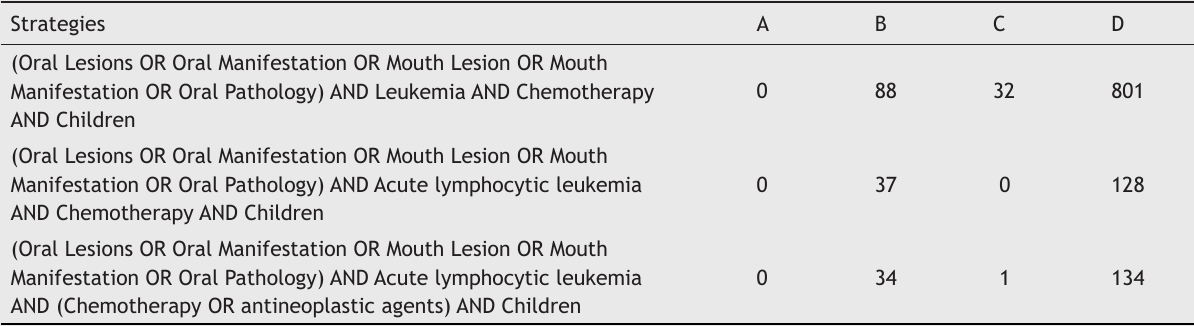
Table 1 Search strategies and number of articles found in the databases.